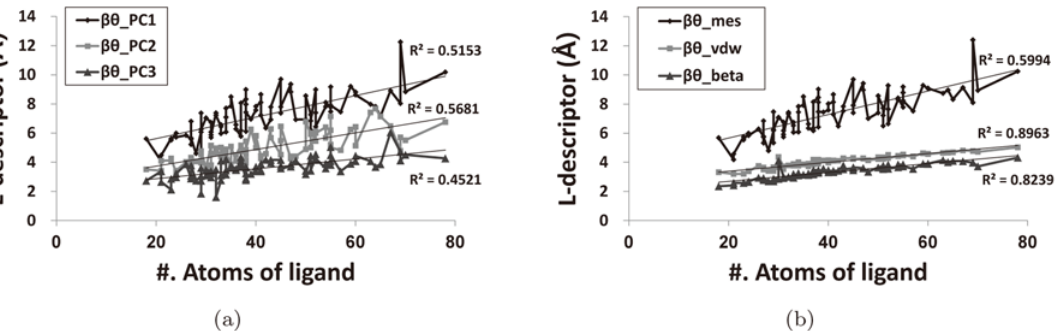
Fig 9. L-descriptor curves with respect to the ligand size. R 2 (the coefficient of determination) is a statistical measure of how close the data are to the fitted regression line. The p-values of the six linear regressions are all less than 10 − 11 .